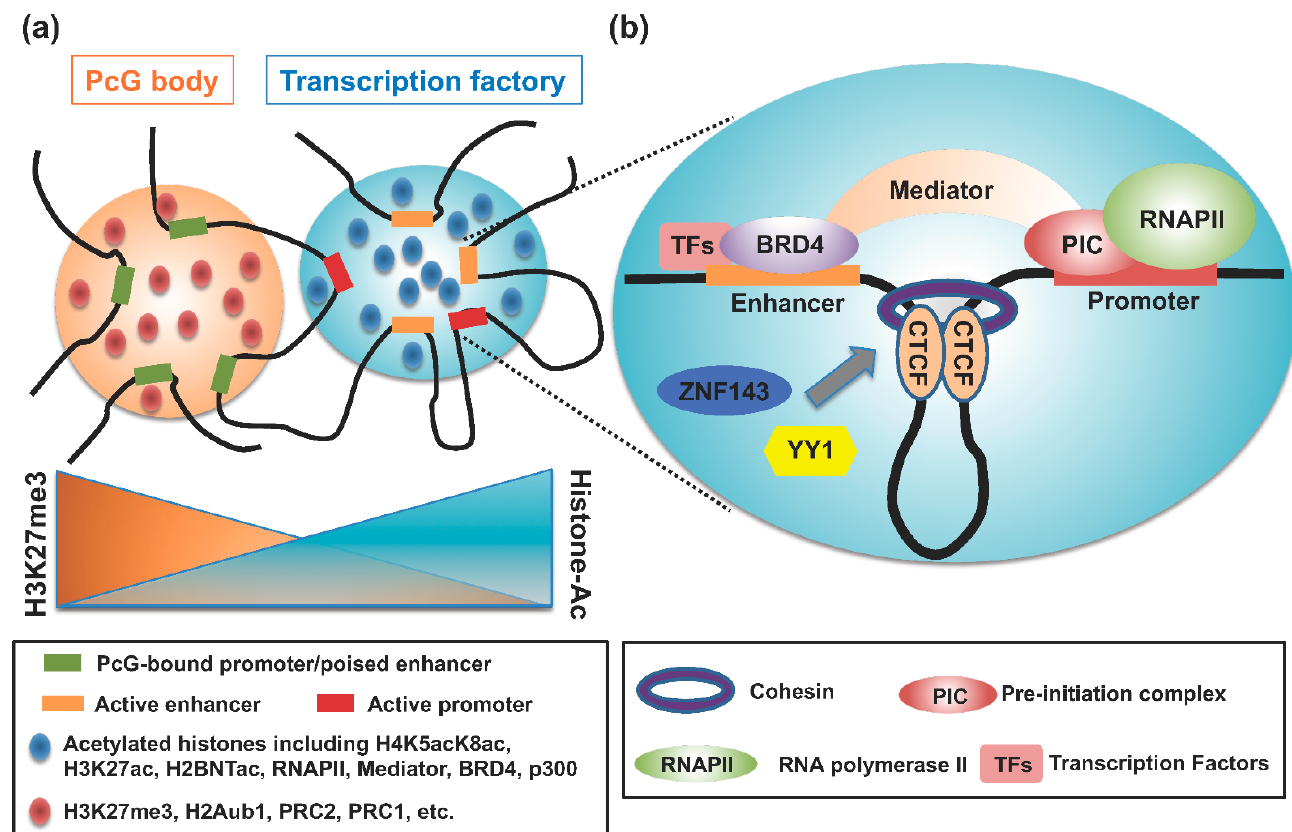
Figure 2. The central role of genome organization in transcription. ( a ) The formation of PcG bodies due to liquid–liquid phase separation (LLPS) organizes PcG-bound chromatin that is enriched in H3K27me3 and H2Aub1. PcG bodies may contain poised enhancers that are marked with H3K27me3 and H3K4me1. At actively transcribed loci, the transcription factory may undergo LLPS, to assemble cell-specific activators, including active histone marks (e.g., H3K27ac, H4K5acK8ac, H2BNTac) and associated transcription factors (TFs), in high concentrations. In addition, super-enhancers may mediate systematic loading of the transcriptional machinery to active gene promoters, and the recently coined ‘enhancer hub’ associated with CTCF and cohesin may have similar properties to LLPS. ( b ) E–P interactions mediated via multiple factors ensure active transcription.